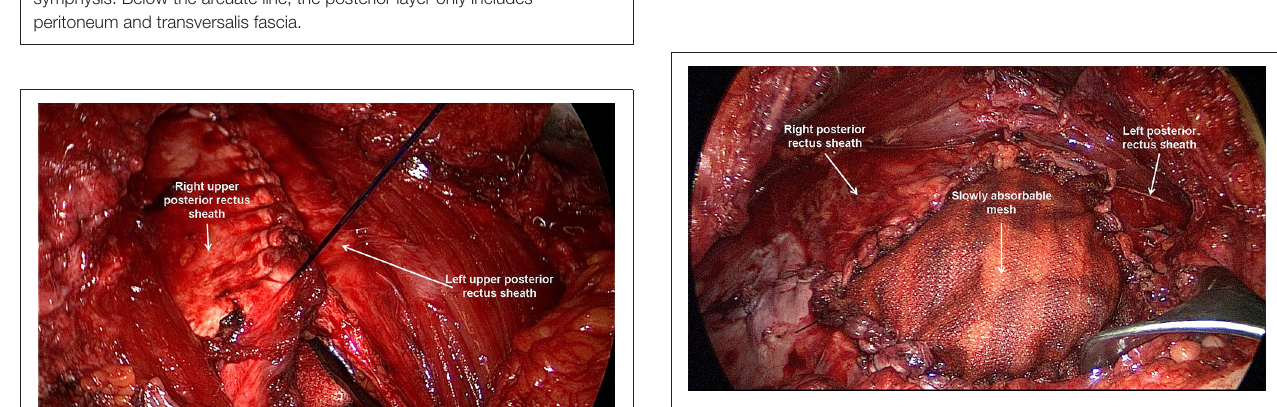
FIGURE 10 | Complete reconstruction of the posterior rectus sheath.